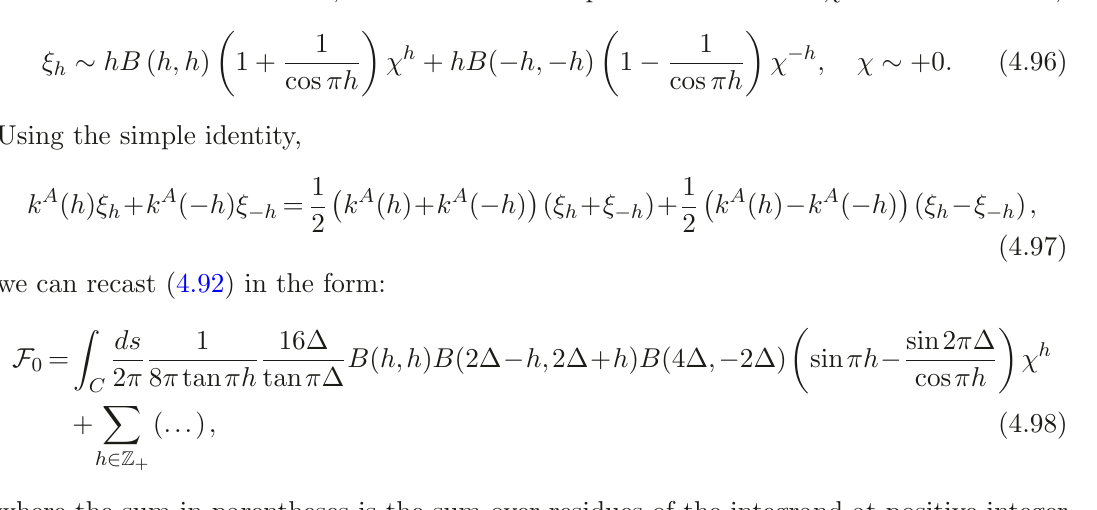
= 2 SYK model avoids the double pole at N